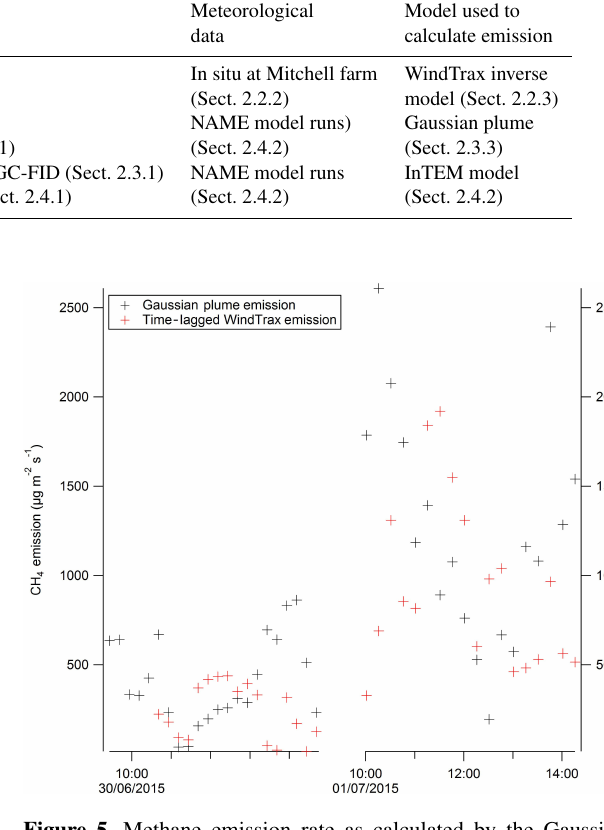
Figure 4. Measured wind speed (top), measured temperature (middle-top), measured pressure (middle-bottom) and methane emission rate as calculated by the WindTrax atmospheric dispersion model (bottom) from data collected at Mitchell Hill Farm, Cotten- ham, from the landfill at the Waterbeach Waste Management Park on 30 June and 1 July 2015.